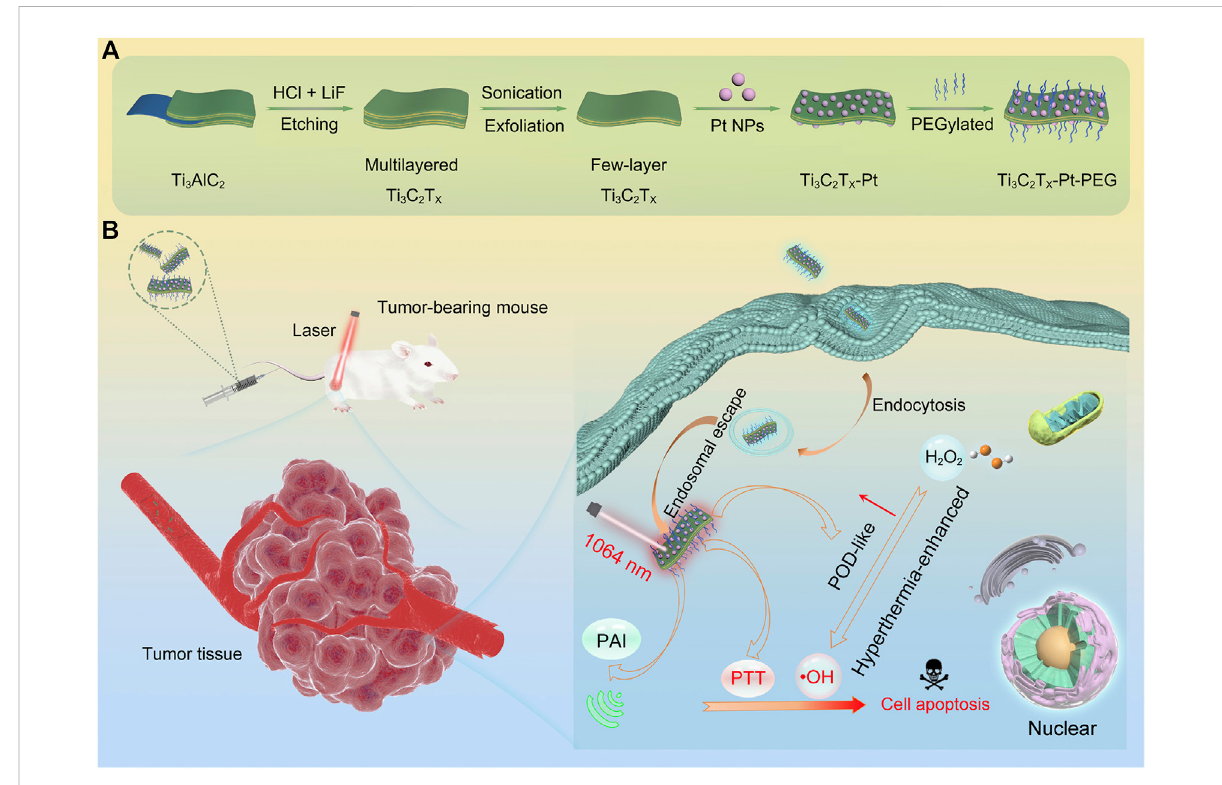
FIGURE 5 Design, fabrication,andcatalytic-therapeuticschematicdiagram ofTi3C2Tx-Pt-PEG. (A) IllustrationofthesyntheticprocedureofTi3C2Tx-Pt- PEG. (B) The schematic diagram ofTi3C2Tx-Pt-PEG withhyperthermia-enhanced nanozyme catalytic activity for cancer therapy(Zhu etal.,2022d). Copyright © 2022 American chemical